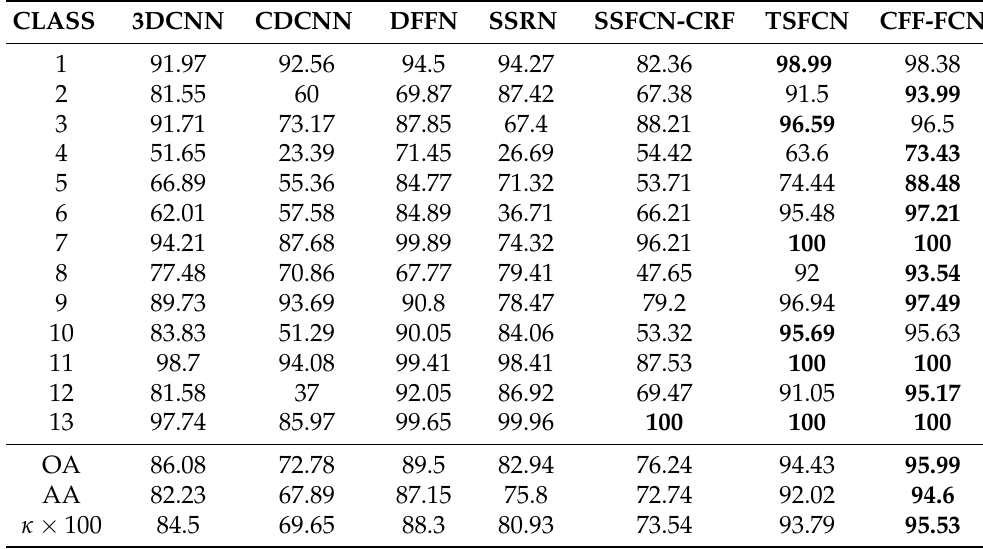
Figure 8. For Kennedy Space Center image. ( a ) RGB composite image of three bands. ( b ) Ground- truth map. ( c ) 3DCNN. ( d ) CDCNN. ( e ) DFFN. ( f ) SSRN. ( g ) SSFCN-CRF. ( h ) TSFCN. ( i ) CFF-FCN. Table 5. Classification accuracy(%) for Kennedy Space Center using different